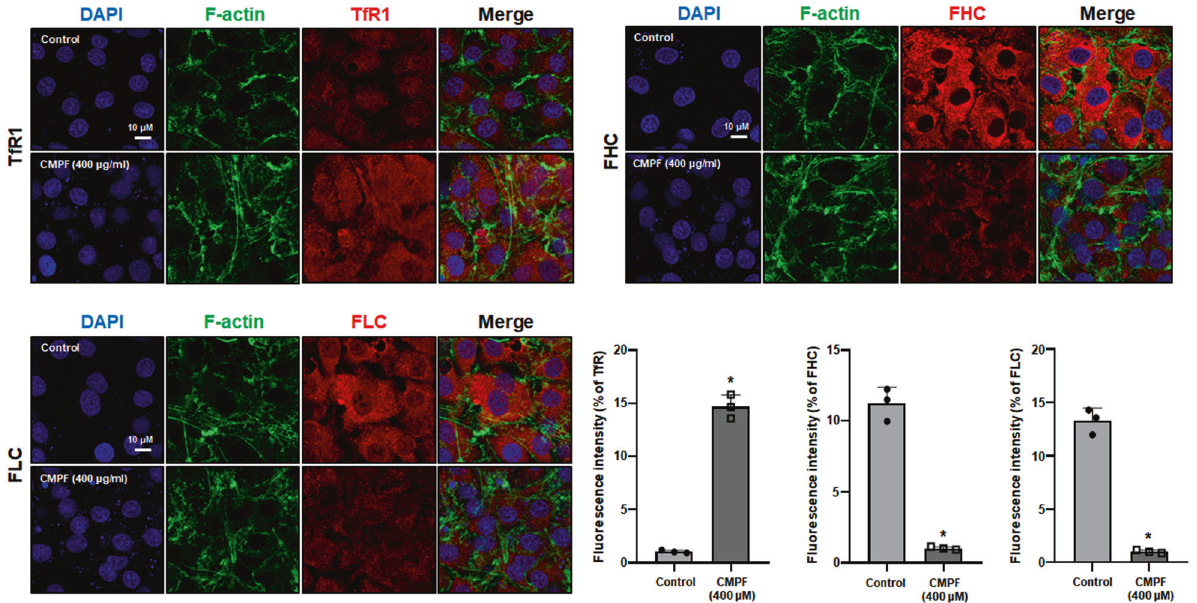
Fig. 6 Immuno fl uorescence analysis of TfR1, FHC, and FLC expression after uremic toxin CMPF treatment in HK-2 cells. HK-2 cells were observed using a confocal microscope treatment with 400 μ M CMPF for 24 h under serum starvation. TfR1, FHC, and FLC are indicated in red, F-actin in green, and nuclei in blue (DAPI). The bar graph shows the fl uorescence intensity. All values are presented as the mean ± SD. Statistical signi fi cance was measured using Mann-Whitney test. *, P < 0.05, compared with the HK-2